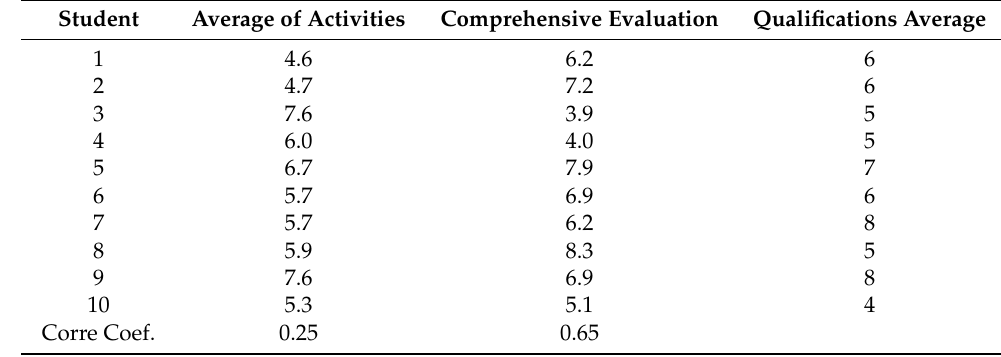
Table 1. Results of data processing, classification of activities versus score of comprehensive evalua- tion period 2019-1.